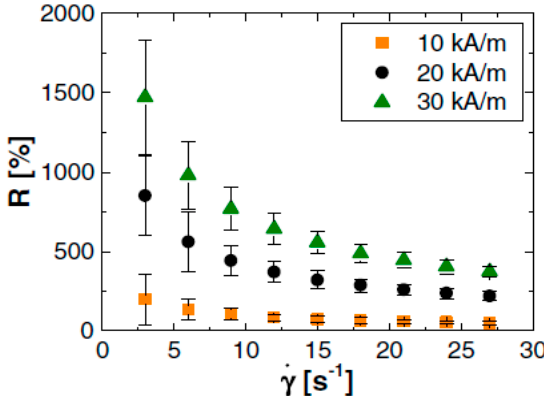
Figure 24. The MVE of the ferrofluid fluidMAG-D-200 nm for three magnetic field strengths depending on the shear rate. Reprinted with permission from Reference [164].